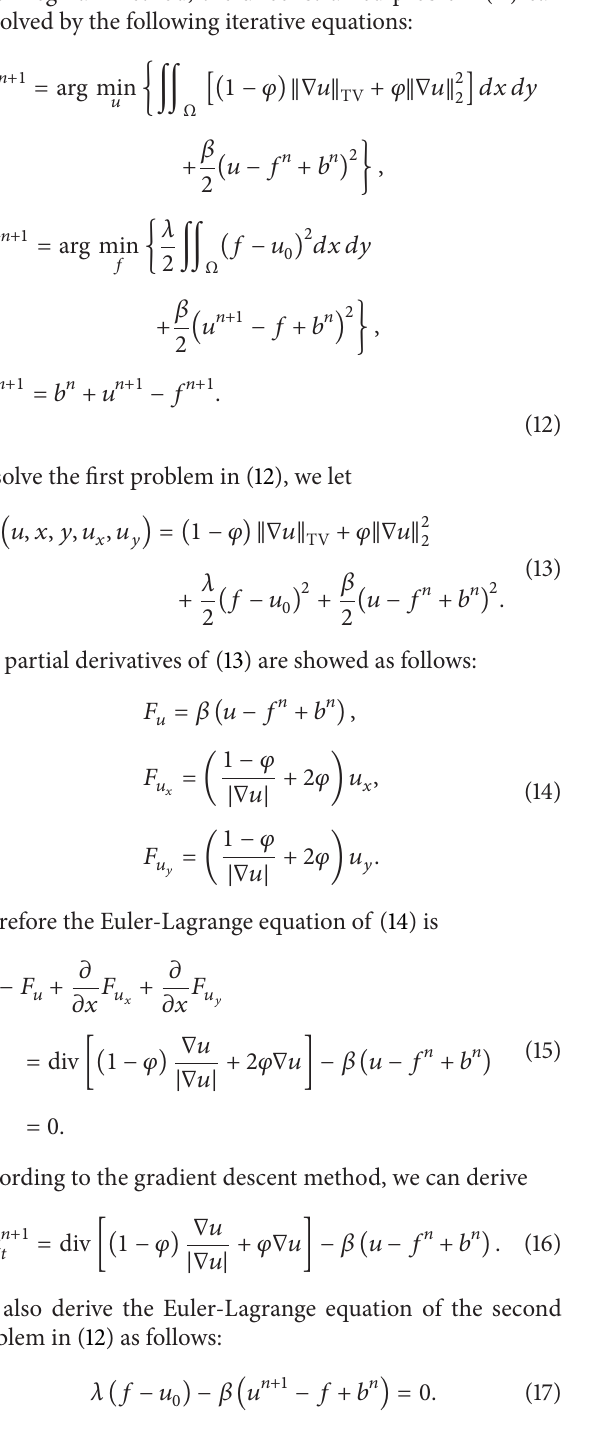
Algorithm 1. The proposed algorithm for image denoising is as